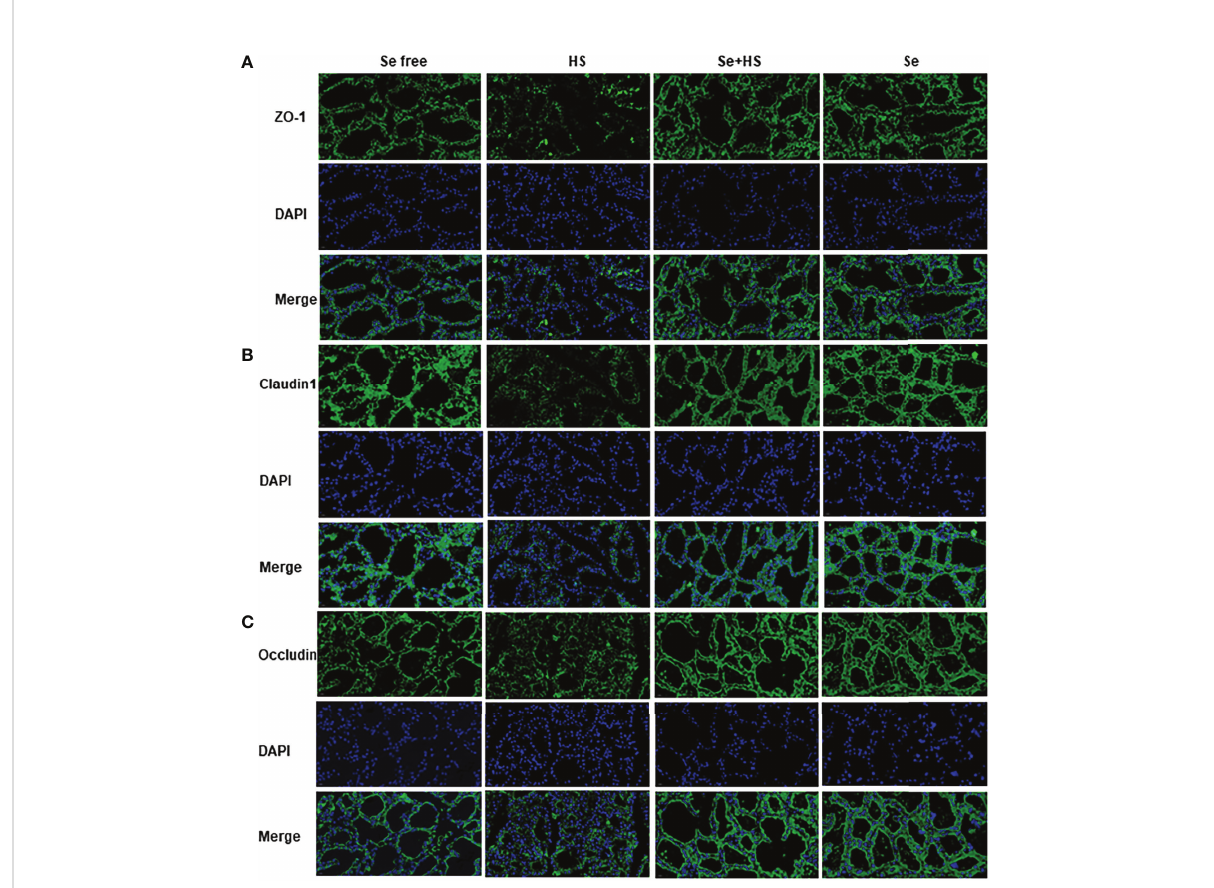
FIGURE 11 Effects of HMSeBA on the immuno fl uorescence of tight junction proteins in the mammary gland of mice under HS (20 ×) (n = 12). Effects of HMSeBA on immuno fl uorescence of tight junction protein ZO-1 (A) , claudin 1 (B) , and occludin (C) were determined using immuno fl uorescence. DAPI marks the nucleus of neutrophils, and the green label marks the tight junction